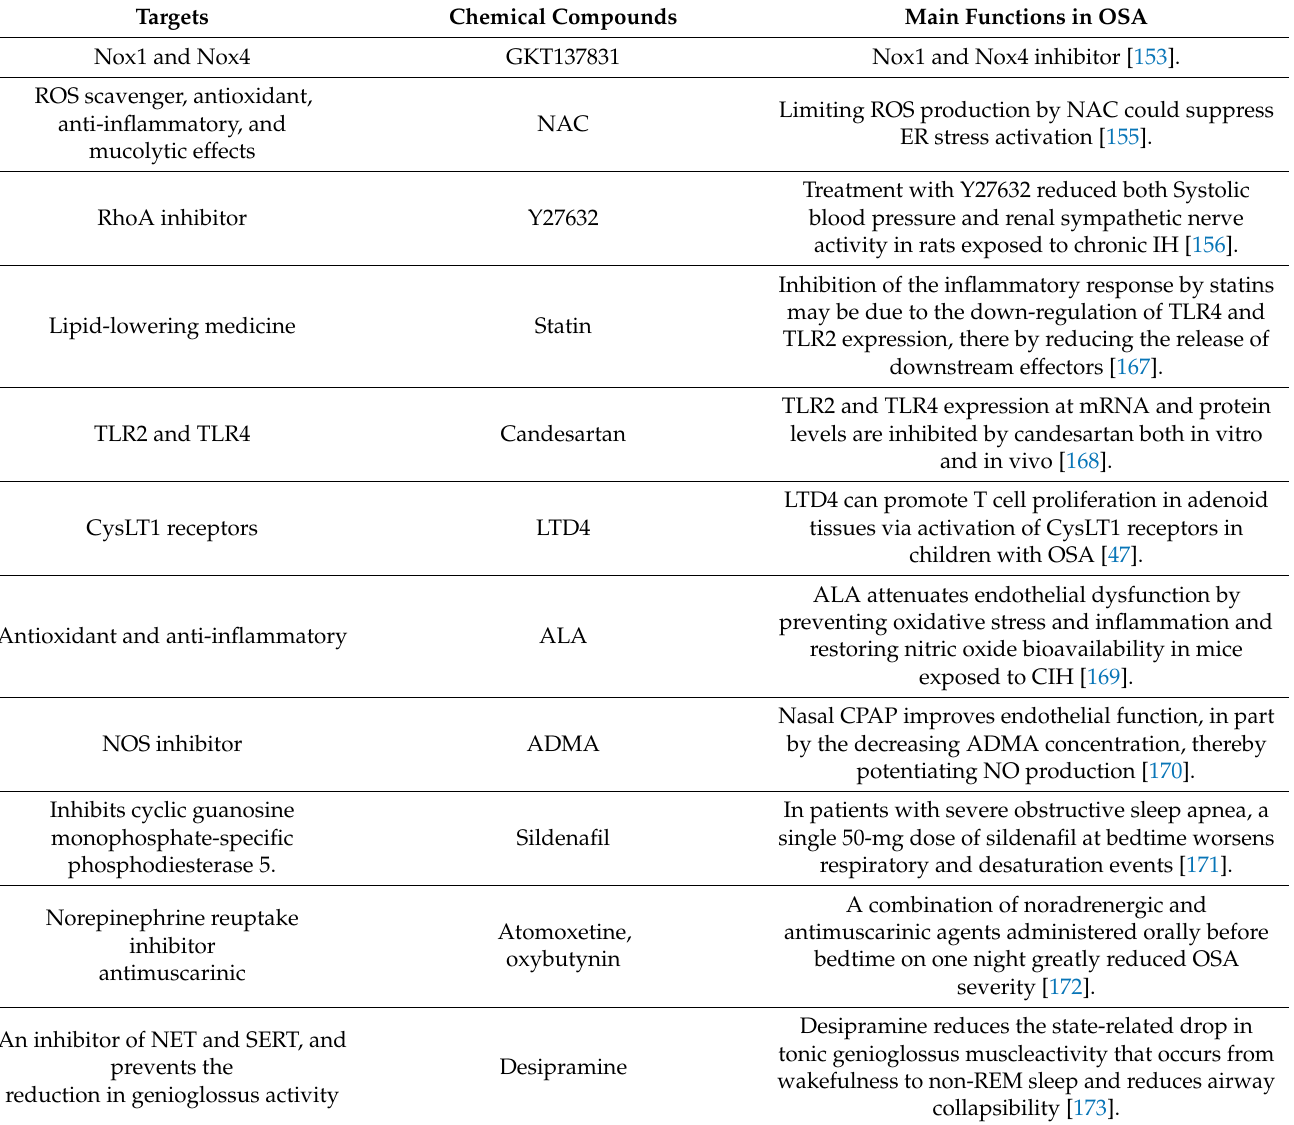
Table 5. The chemical compounds involved in